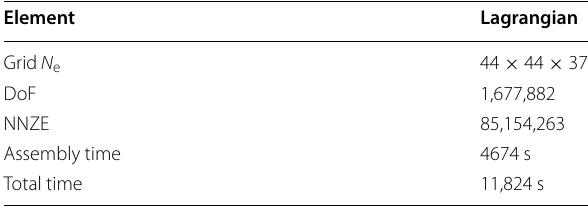
Table 3 Time and memory used in MoVFEM with COMMEMI 3D‑2